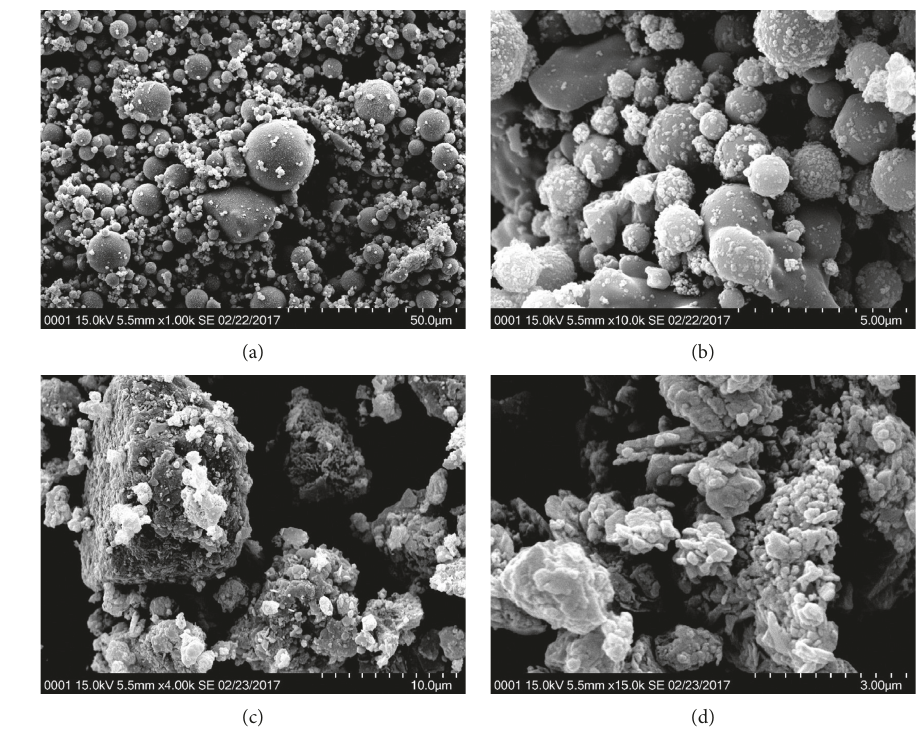
Figure 2: SEM micrographs of fly ash (FA)—(a, b) and waste concrete (WC)—(c,